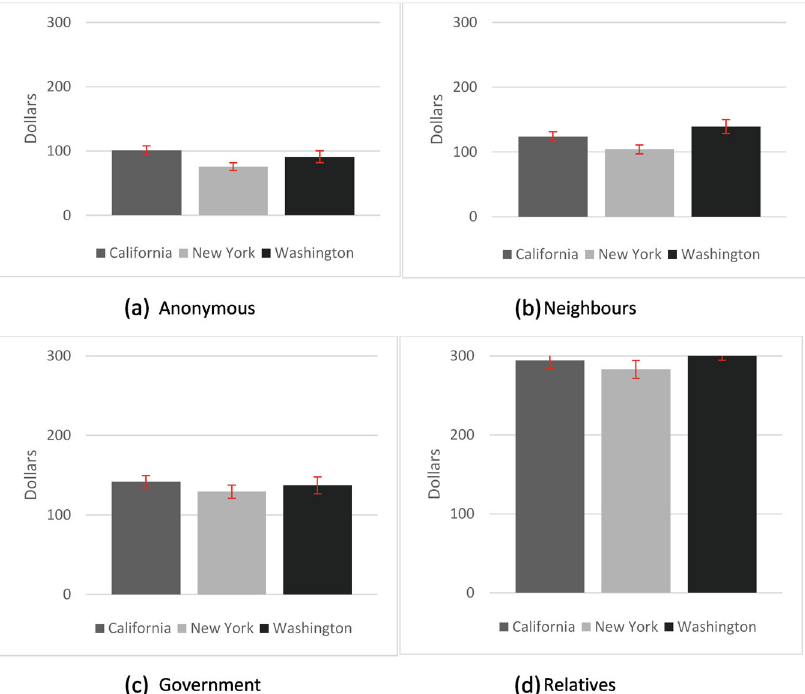
Fig. 4 Average donations by state, for each dictator game type. Mean donations in California, New York and Washington states, by the four dictator game types: a anonymous b neighbour c government d relative.